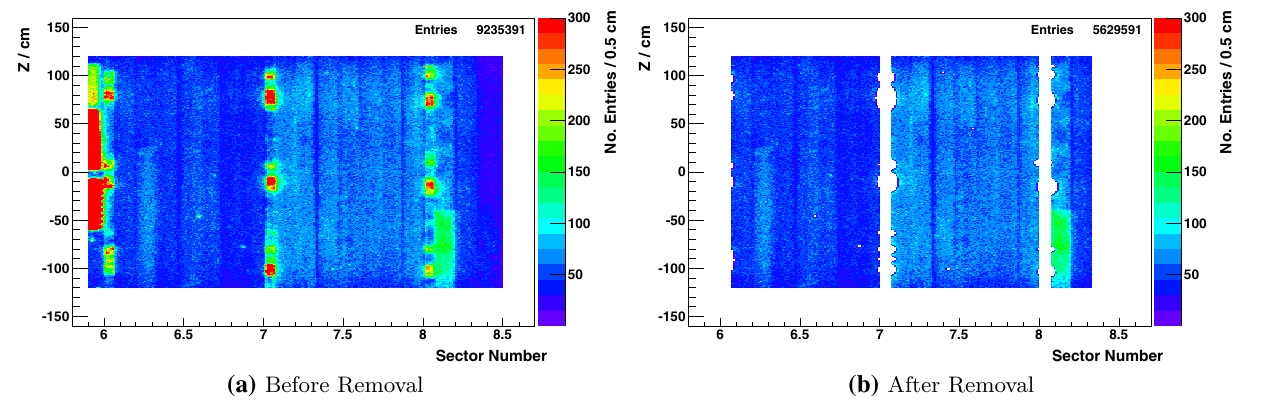
Fig. 1 The sectors of the detector containing the 82 Se source foils, imaged in the 1e channel. a Shows the reconstructed vertex from all single electron events. b Shows the same region after removing events originating from neighbouring foils, calibration tubes and areas with ous emission from the same location in a 82 Se foil are used to measure internal contamination by radioactive